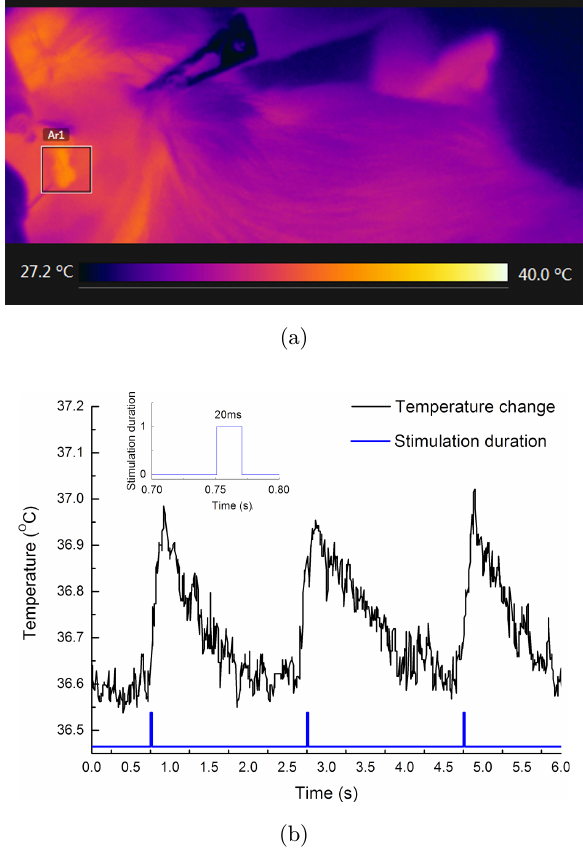
Fig. 7. (a) Depicts temperature measurement of cochlea of a guinea pig. (b) The dotted line shows the starting time of stimulation and duration is 20 ms. The solid line shows tem- perature changes in the block diagram